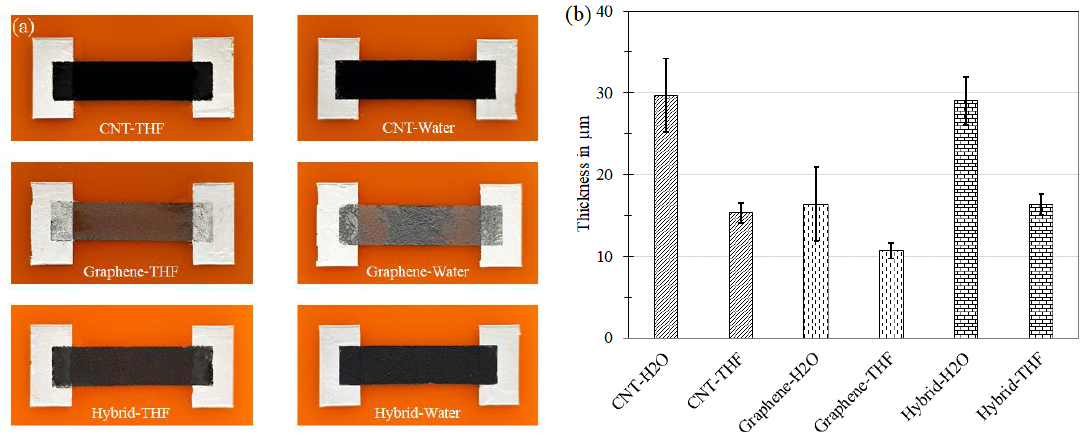
Figure 3. ( a ) Images of the fabricated thin films, ( b ) graph representing the average thickness of each sample.